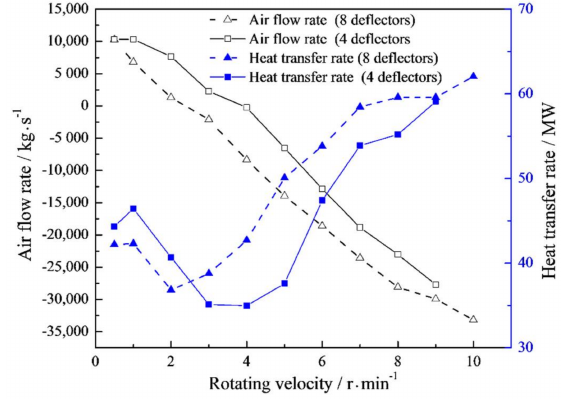
Figure 20. Air flow rate and heat transfer rate versus rotating velocity of four and eight wind deflectors under 5 m/s crosswind